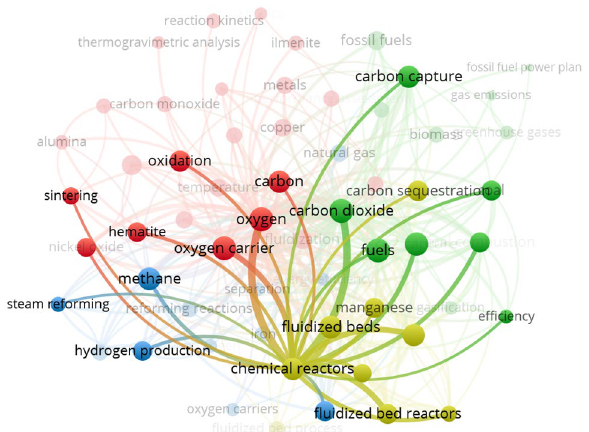
Fig. 11 Bibliometric map (CLC) (Source: www. vosvi ewer. com)